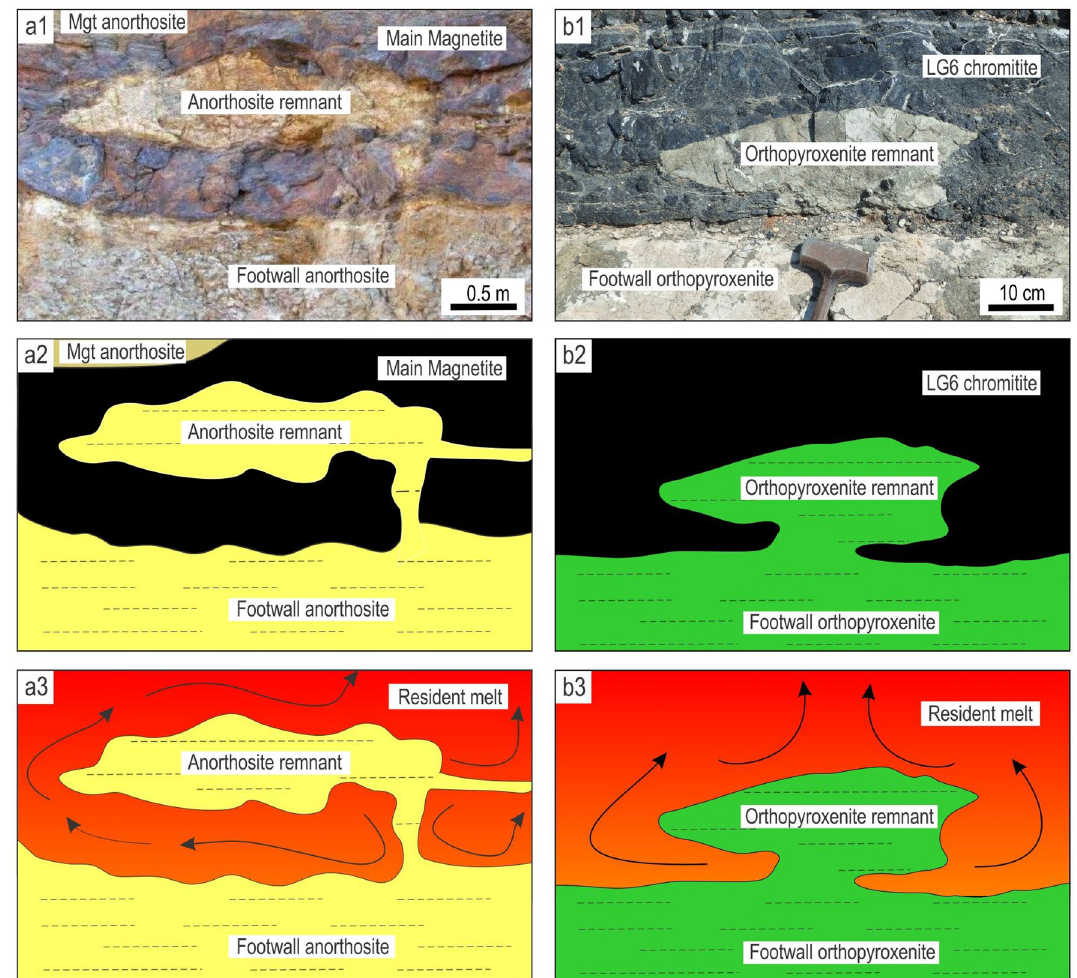
Figure 6. The morphology of the undercut-embayed chamber floor from different localities of the Bushveld Complex, South Africa. (a1, a2, a3) , Photo, sketch and reconstruction of an erosional remnant of anorthosite that is hosted by the Main Magnetite Layer and is still attached to the footwall rocks. Vametco Vanadium Mine, Upper Zone of the Western Bushveld Complex. (b1, b2, b3) , Photo, sketch and reconstruction of an erosional remnant of orthopyroxenite that is hosted by the LG6 chromitite and is still attached to the footwall rocks. Jagdlust area, Lower Critical Zone of the Eastern Bushveld Complex. (c1, c2, c3) , Photo, sketch and reconstruction of erosional remnants of anorthosite that are hosted by the Merensky Reef orthopyroxenite and are still attached to the footwall rocks. Karee Platinum Mine, Upper Critical Zone of the Western Bushveld Complex. (d1, d2, d3) , Photo, sketch and reconstruction of an erosional remnant of orthopyroxenite that is hosted by the overlying norite/ anorthosite and is still attached to the footwall rocks. Modikwa Platinum Mine, Upper Critical Zone of the Eastern Bushveld Complex. (e1, e2, e3) , Photo, sketch and reconstruction of in situ erosional remnants of anorthosite that are hosted by the Merensky Reef orthopyroxenite and seemingly not attached to the footwall rocks in this section. Remnants appear to have retained their original positions and orientations. Brakspruit Pothole, Rustenburg Platinum Mine, Upper Critical Zone of the Western Bushveld Complex. (f1, f2, f3) , Photo, sketch and reconstruction of in situ erosional remnants of orthopyroxenite that are hosted by the MG2 chromitite and seemingly not attached to the footwall rocks in this section. Remnants appear to have retained their original positions and orientations. Hoggenoeg Chrome Mine, Upper Critical Zone of the Eastern Bushveld Complex. In all the above examples, the morphology of the undercut-embayed floor is attributed to magmatic karstification (i.e. erosion by dissolution) of the chamber floor cumulates by new magma pulses that replenish the chamber. The figure is prepared using CorelDRAW (version